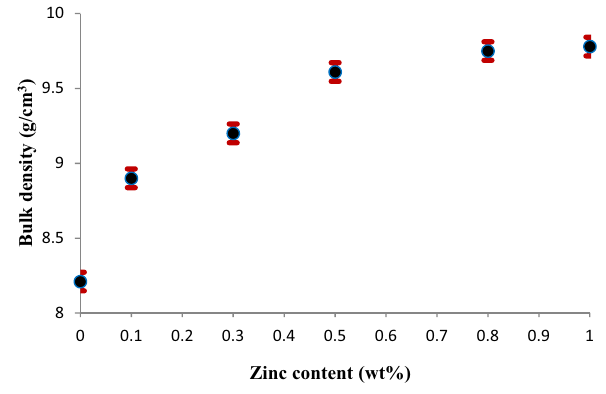
Fig. 3 Bulk density of silicon bronze with varying zinc nano-parti- cles content